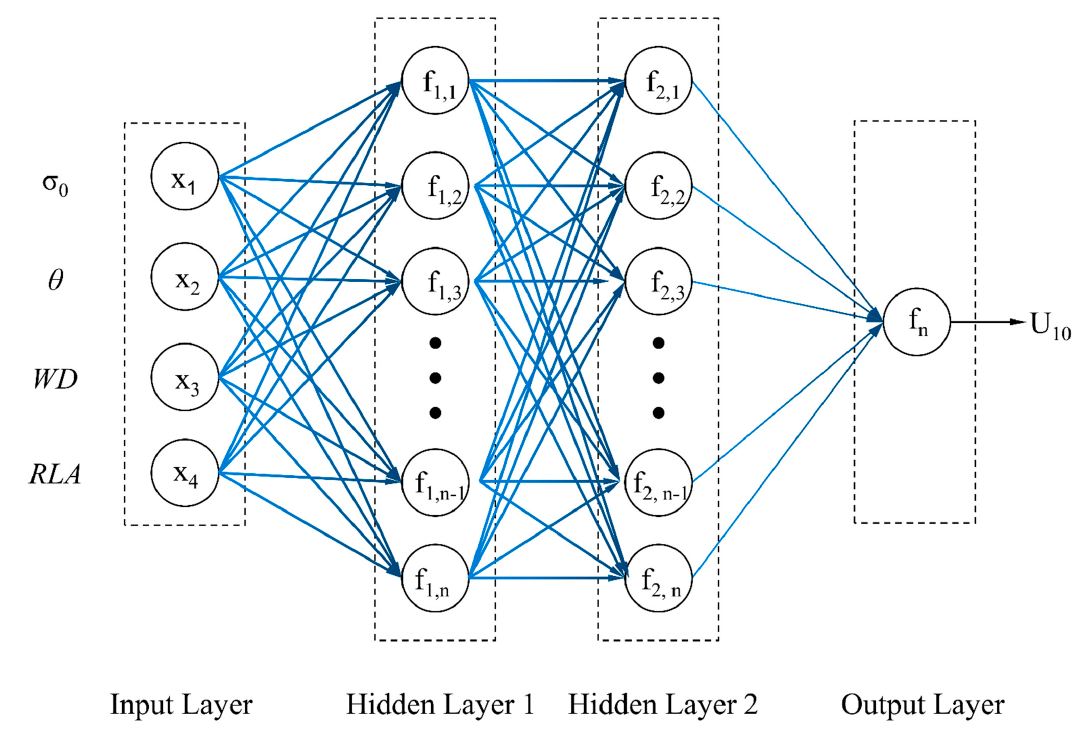
Figure 4. Flowchart of the structure of the OPEN model. The root-mean-squared error (RMSE), correlation coefficient (R), mean absolute per- centage error (MAPE), and bias are used to evaluate the wind results in this research. Because an explicit cross-validation subset is not required to ensure generalization based on the Bayesian Regularization algorithm, 98% of the collocated data (52,337 points) are randomly selected as the training set. The colormap represents the sample counts. The comparison between the OPEN results and labeled wind data from NDBC buoy measure- ments can be seen in Figure 5. The relatively small RMSE (less than 1.2 m/s) and bias (less than 0.01 m/s) indicate that the OPEN model fits the label wind data well.